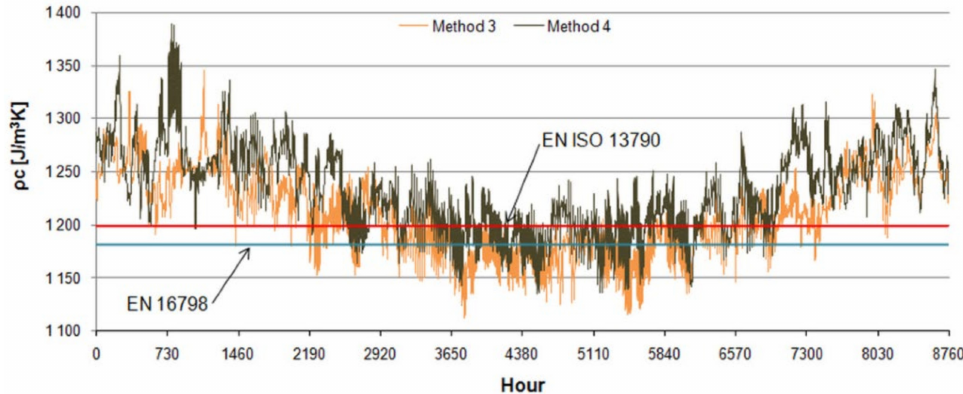
Figure 17. Volumetric specific heat of air according to various methods